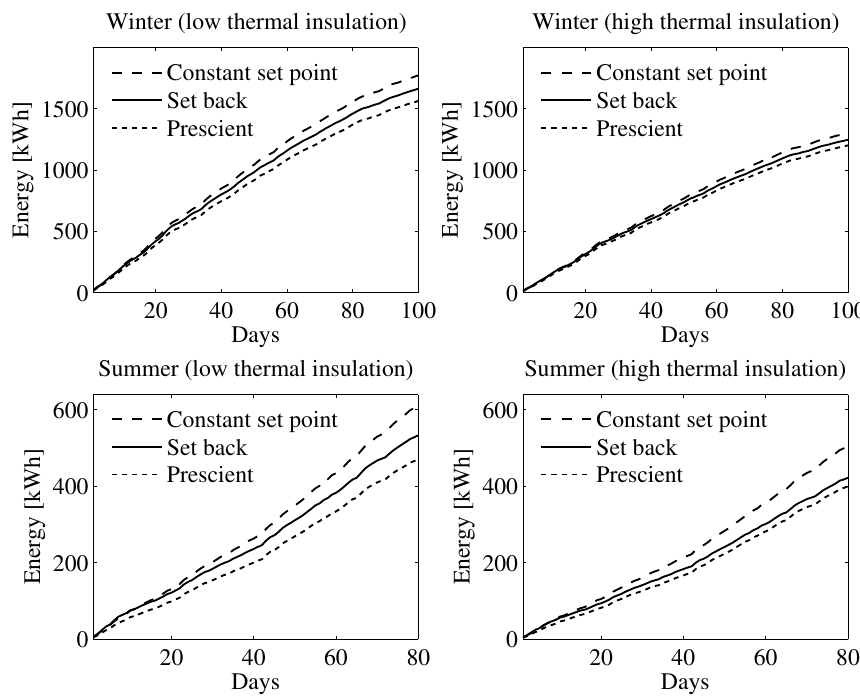
Figure 4. Cumulative energy plot of the default constant set-point strategy, our learning agent with a set-back strategy and a prescient set-back strategy.